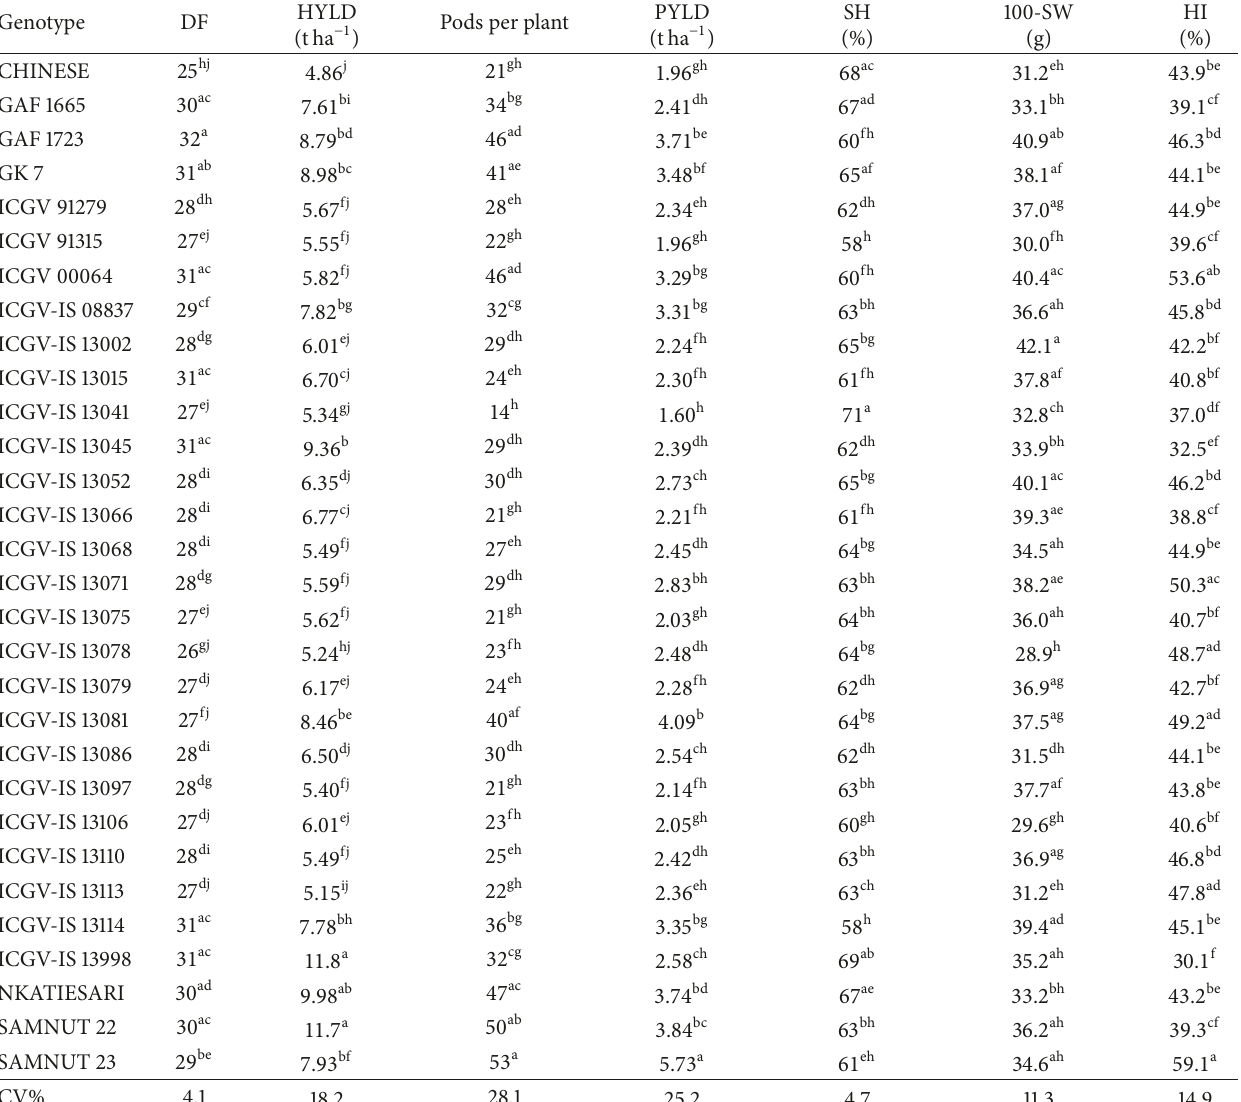
DF: days to 50 % flowering, HYLD: dry haulm yield at harvest, PYLD: pod yield, SH: shelling percentage, 100-SW: weight of a 100 seeds, and HI: harvest index. Mean values followed by dissimilar letters in each column are significantly different ( 𝑝 < 0.05